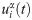
Illustration of population models on the microscopic and mesoscopic level.(A) Cortical column model [5] with ∼ 80’000 neurons organized into four layers (L2/3, L4, L5, L6) each consisting of an excitatory (“e”) and an inhibitory (“i”) population. On the microscopic level, each individual neuron is described by a generalized integrate-and-fire (GIF) model with membrane potential uiα(t), dynamic threshold ϑiα(t) and conditional intensity fα(uiα(t)-ϑiα(t)). Inset: GIF dynamics for a specific neuron i of population L4e (α = L4e). The neuron receives spikes from neurons in L4e, L4i and L6e, which drive the membrane potential uiα(t). Spikes are elicited stochastically by a conditional intensity λiα(t)=fα(uiα(t)-ϑiα(t)) that depends on the instantaneous difference between uiα(t) and the dynamic threshold ϑiα(t). Spike feedback (voltage reset and spike-triggered threshold movement) gives rise to spike history effects like refractoriness and adaptation. (B) Spike raster plot of the first 200 neurons of each population. The panels correspond to the populations in (A). Layer 4 and 6 are stimulated by a step current during the interval (0.06s, 0.09s) mimicking thalamic input (gray bars). Solid lines show the population activities ANα(t) computed with temporal resolution Δt = 0.5 ms, cf. Eq (2). The activities are stochastic due to the finite population size. (C) On the mesoscopic level, the model reduces to a network of 8 populations, each represented by its population activity ANα(t). Inset: The mesoscopic model generates realizations of ANα(t) from an expected rate A¯α(t), which is a deterministic functional of the past population activities. (D) A corresponding simulation of the mesoscopic model yields population activities with the same temporal statistics as in (B).